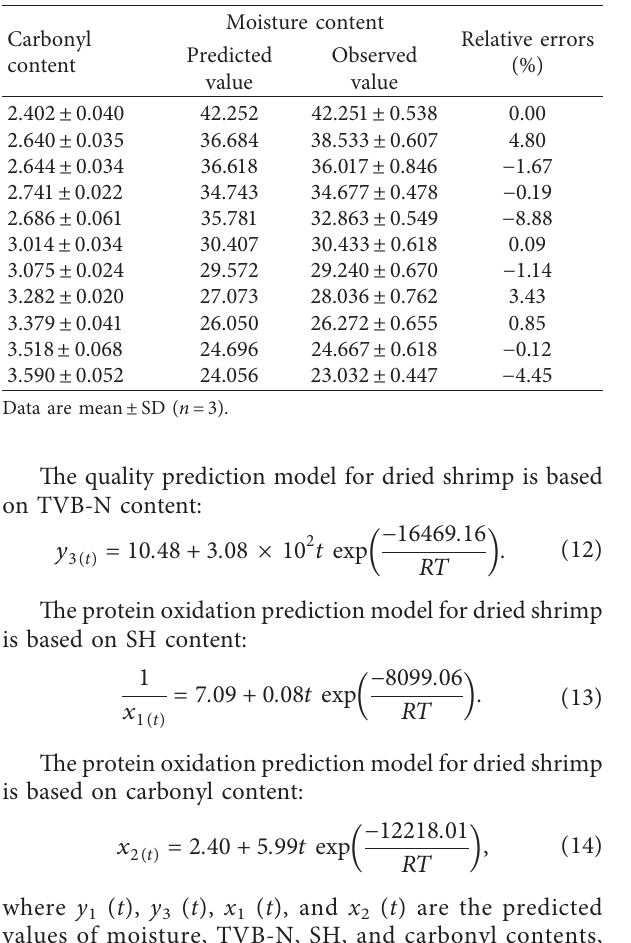
Table 4: Predicted and observed values of moisture content for dried shrimps at